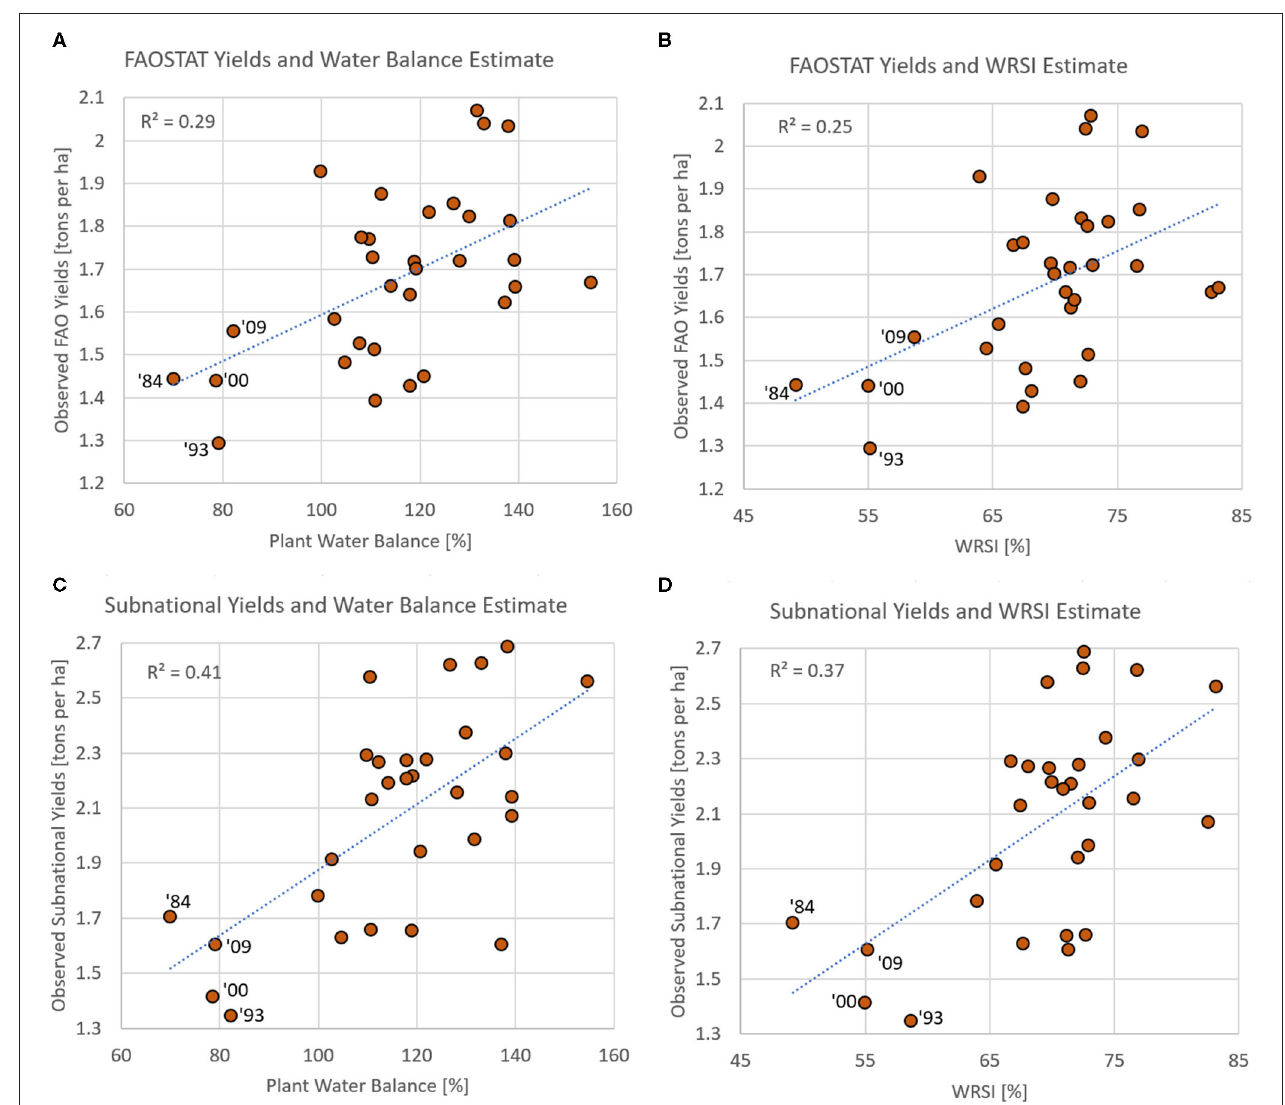
FIGURE 5 | Comparisons (scatterplots) showing Kenyan FAOSTAT national yields (y-axis) and Plant Water Balance (A) and WRSI (B) (x-axis) in key crop-growing counties in Kenya. (C, D) Show similar results based on sub-national yields from these counties. The FAOSTAT time-series extends from 1982 to 2019, the sub-national yields extend from 1982 to